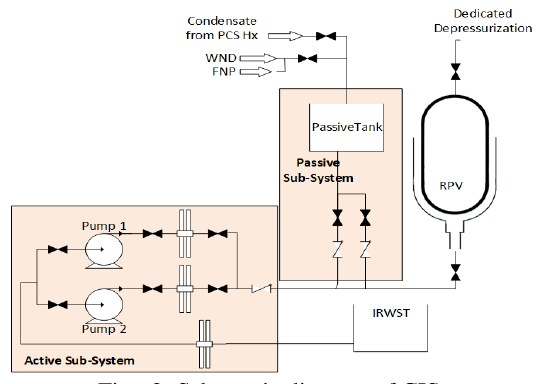
Fig. 2: Schematic diagram of